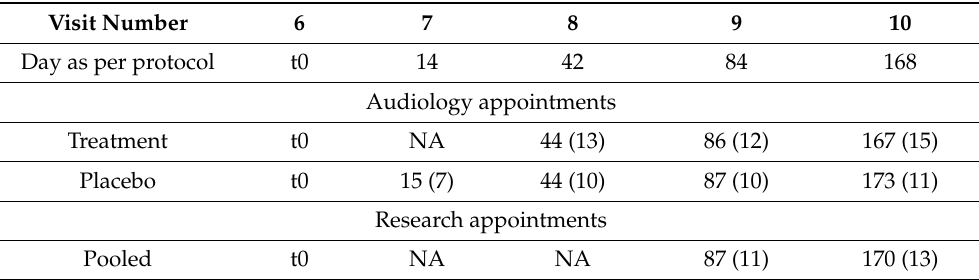
Table 5. Fidelity of audiology and research appointments in the open-label extension. Audiology appointments were for clinical assessment and follow-up. Research appointments were restricted to outcome assessments. Fidelity is calculated relative to the end of the RCT phase (visit 6), with visit 10 at 36 weeks after initial device fitting. Mean across participants in days; standard deviation in